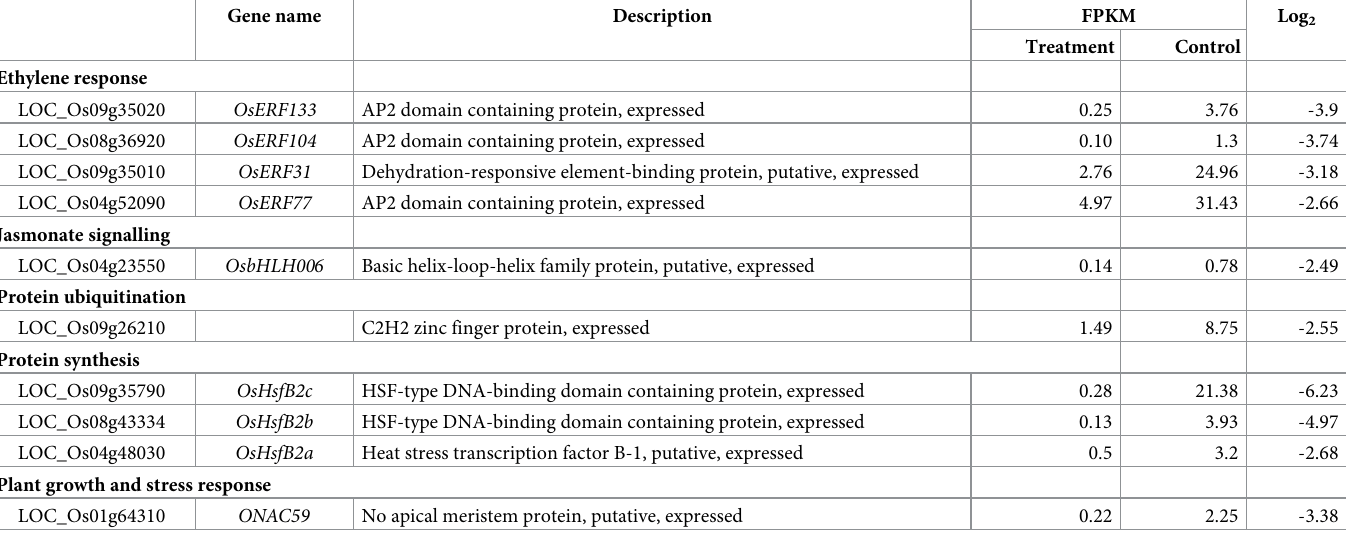
Table 5. The expression profile of downregulated transcription factor families in the 100 most differentially expressed genes in T16.